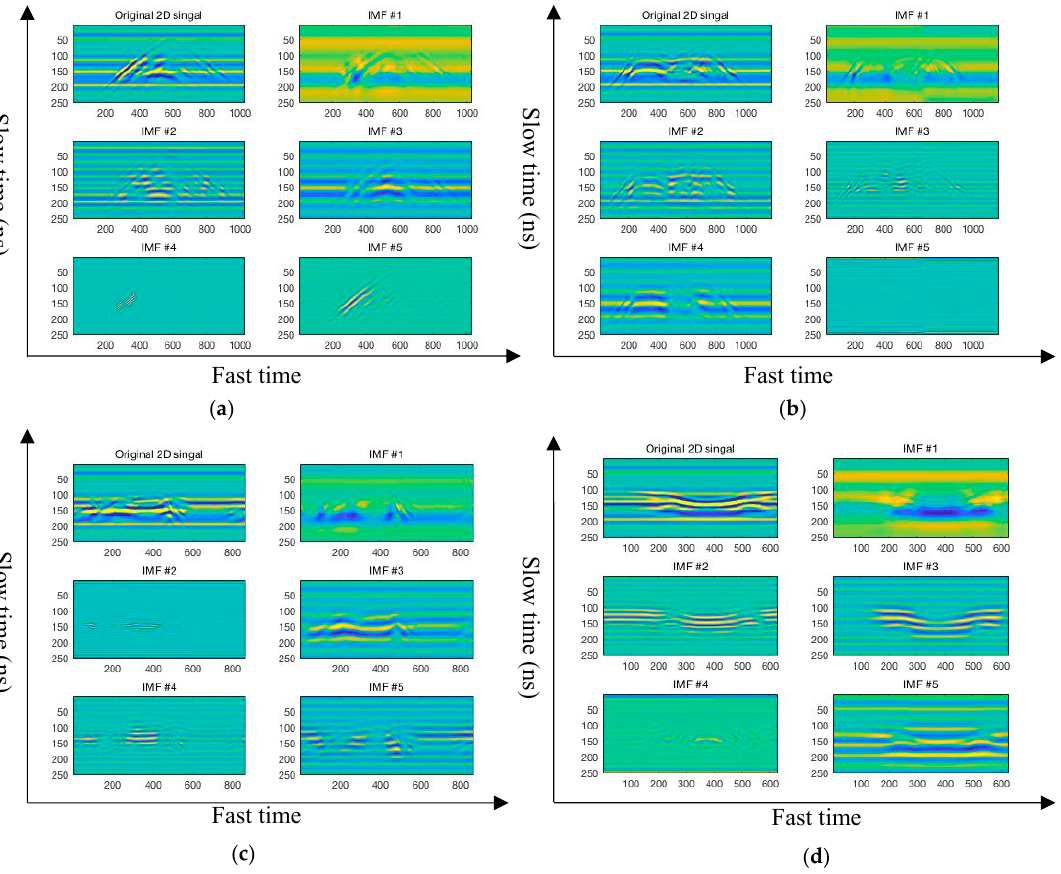
Figure 5. Four di ff erent types of human motion 2D echo signals and several BIMF components after 2D-VMD decomposition. ( a ) Walk forward of human motion 2D echo signal and several BIMF components; ( b ) fall forward of human motion 2D echo signal and several BIMF components; ( c ) walk around of human motion 2D echo signal and several BIMF components; and ( d ) jump forward of human motion 2D echo signal and several BIMF components.